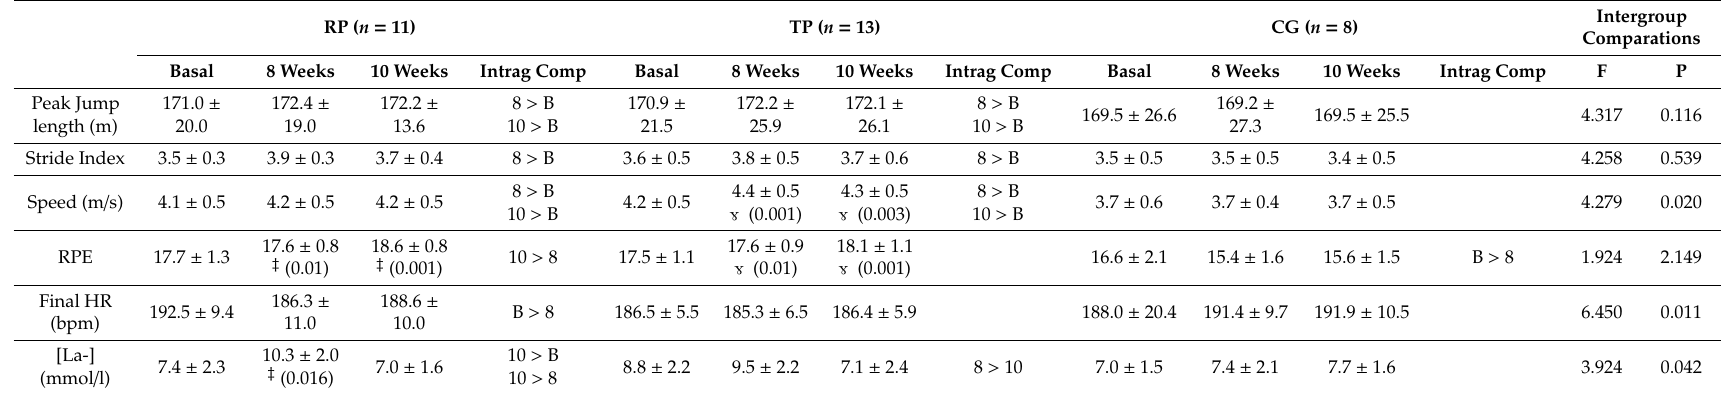
Table 5. Data of jump and running performance test before, after 8 weeks of training, and after two weeks of tapering in the three groups, mean ±